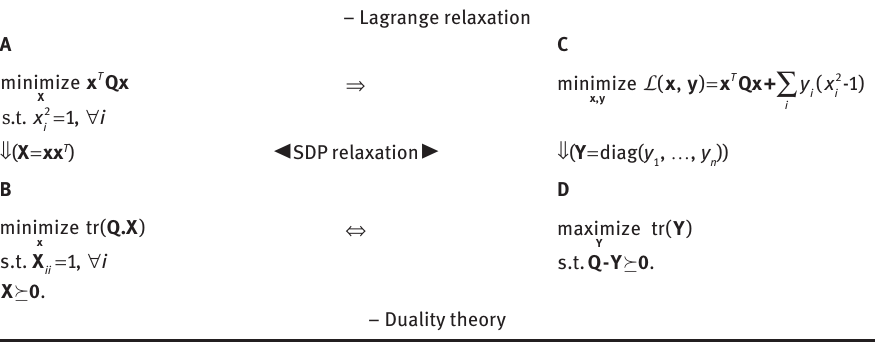
Table B2: Lagrange and SDP relaxation for a binary QP problem. – Lagrange relaxation